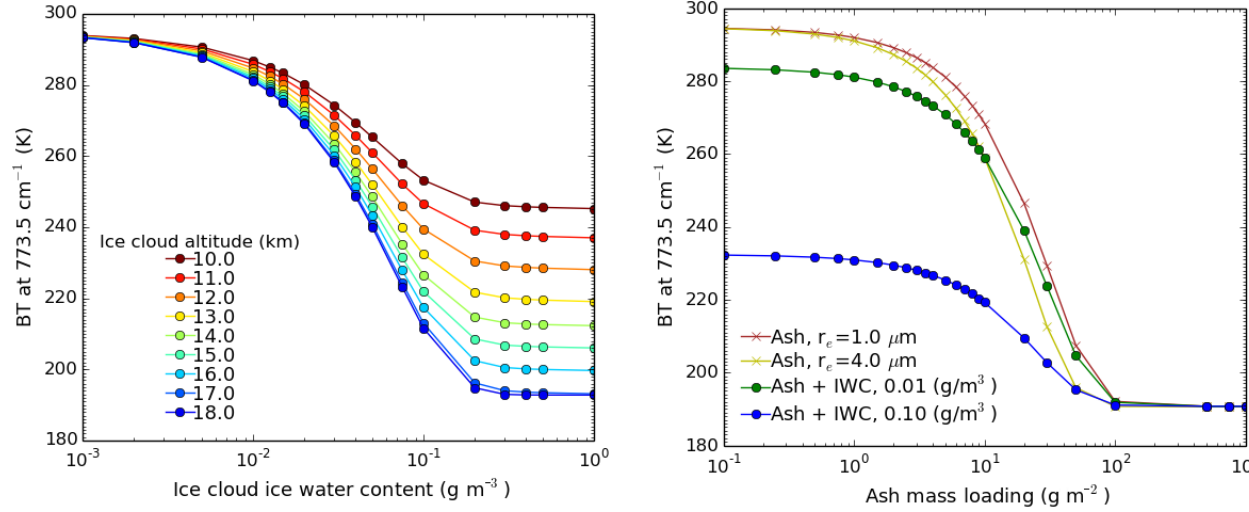
Figure 5. (Left panel) The brightness temperature at 773.5cm − 1 as a function of ice water content for ice clouds at various altitudes. (Right panel) The 773.5cm − 1 brightness temperature as a function of ash mass loading for pure ash cloud (lines with crosses) with effective radii r e = 1 . 0, 4.0µm, and an ash cloud with r e = 1 . 0µm overlying an ice cloud at 13km with IWC = 0.01 and 0.1gm − 3 (lines with